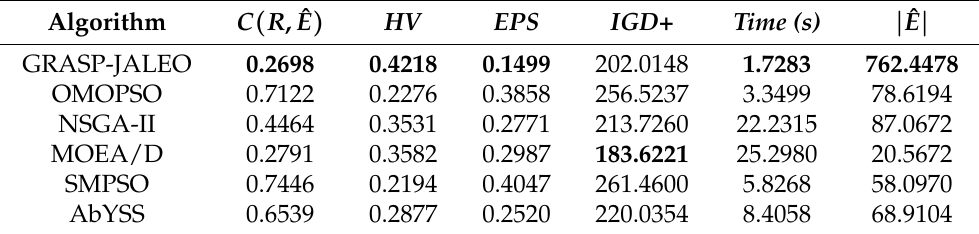
Table 7. Competitive testing of the GRASP, NSGA-II, MOEA/D, SMPSO, and AbYSS.